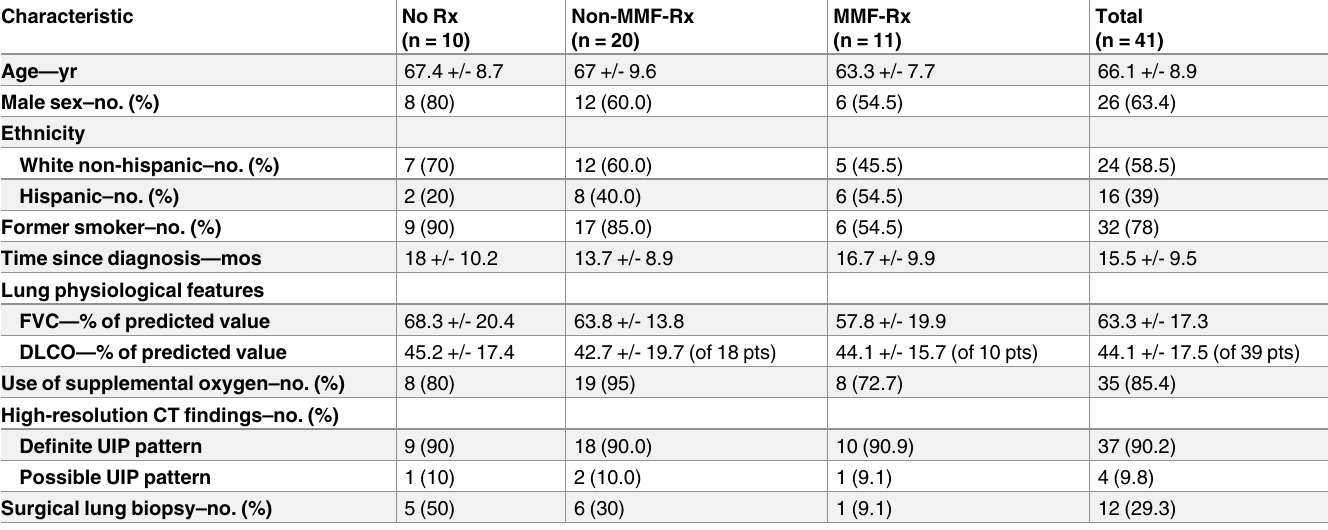
Table 1. Baseline patient characteristics.